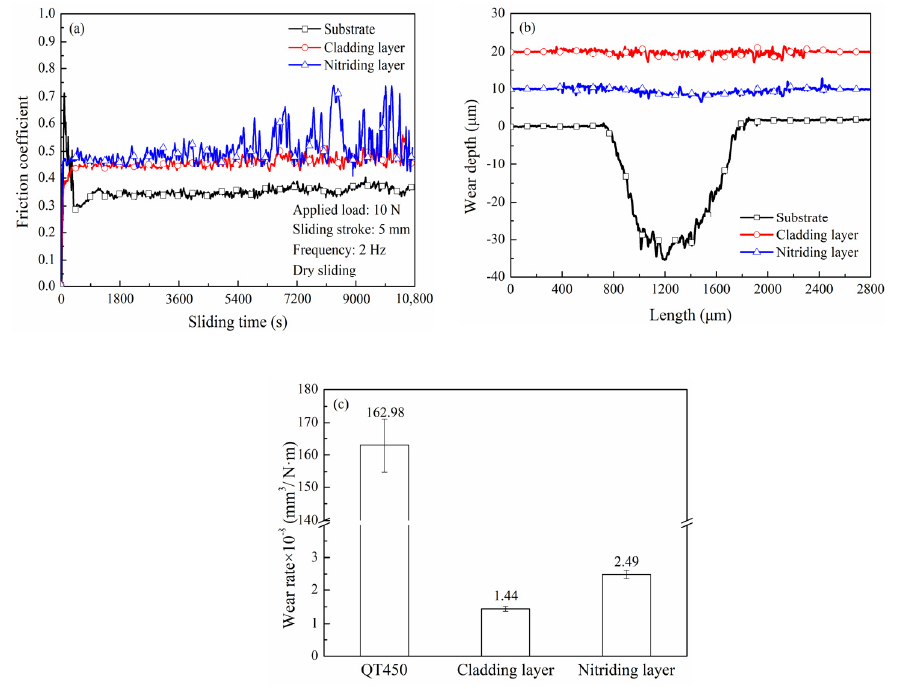
Figure 5. Friction coefficients of three samples at loads of: ( a ) 100 N, ( b ) 200 N, and ( c ) 300 N under starved lubrication conditions.